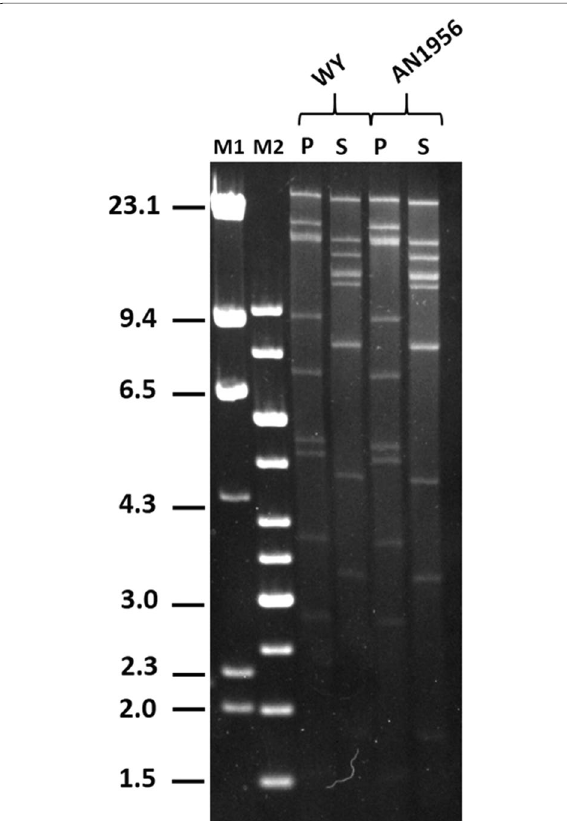
Fig. 3 Comparison of DNA restriction profile patterns of Spodoptera littoralis nucleopolyhedrovirus SpliNPV-WY isolate upon digestion using Ps tI and Sc aI endonucleases compared to the pattern of the reference strain (SpliNPV-AN1956). Fragments were separated by electrophoresis in 0.8% agarose gel in 1% TAE. M1: Lambda Hin dIII DNA ladder (Thermo Fisher); M2: 1 kb ladder. WY: SpliNPV-WY, AN1956: SpliNPV-AN1956, P: Ps tI and S: Sc aI endonucleases